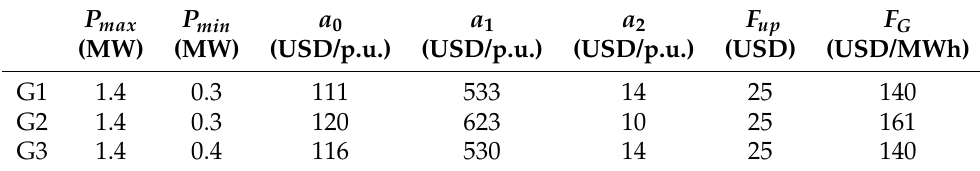
Table 1. Economic and operating parameters of